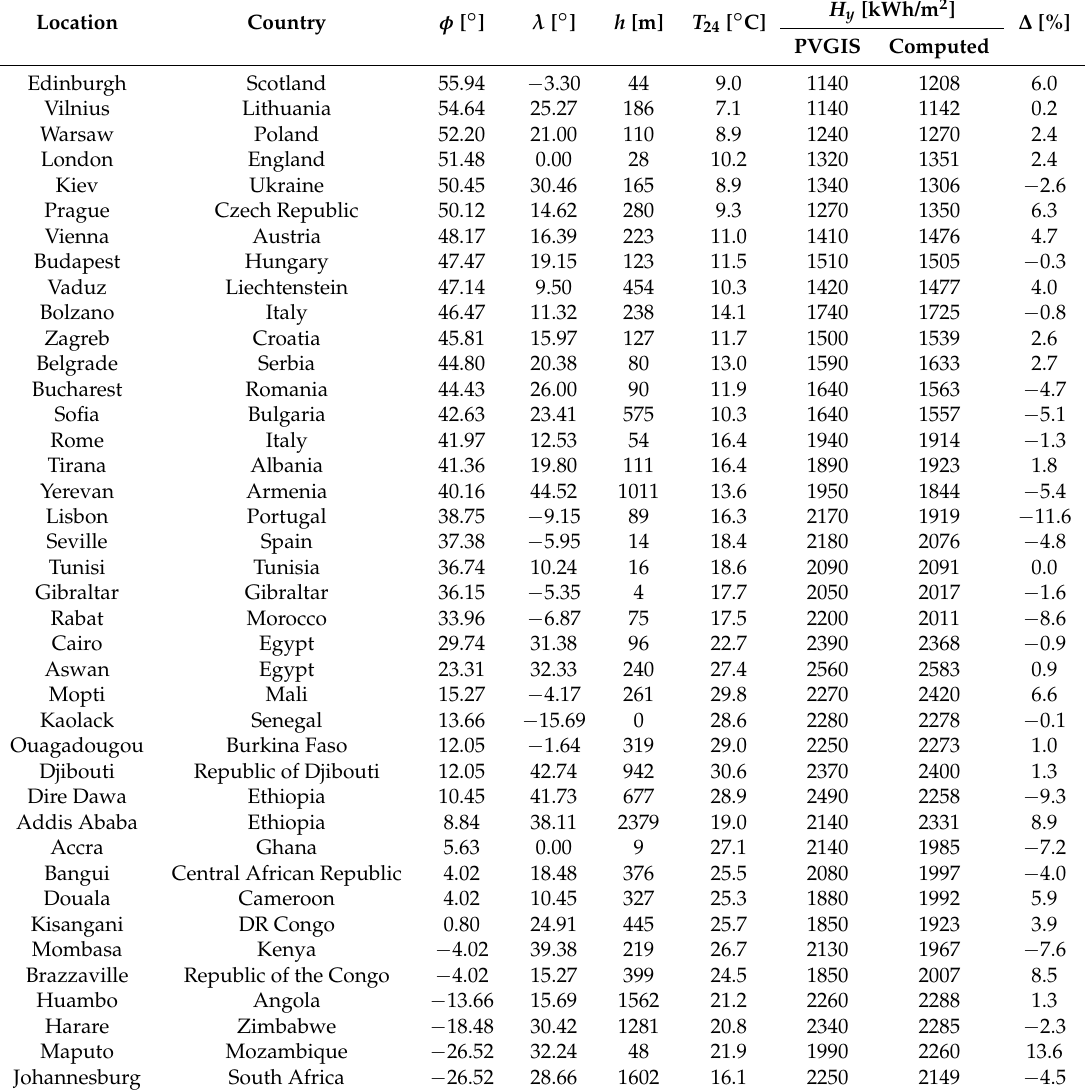
Table A1. Locations in Europe and Africa considered to train and validate the multiple-regression method. For each location, latitude ( φ ), longitude ( λ ), altitude ( h ), and mean temperature over 24 h ( T 24 ) are reported. The yearly sum of the global solar irradiation ( H y ) as obtained from the PVGIS tool [37] and the proposed estimator are compared. The last column reports the relative error of the estimates with respect to the PVGIS data. Note that the exact geographical coordinates have been chosen based on the availability of the required data, and the indicated cities/places represent the most significant locations nearby the considered geographical